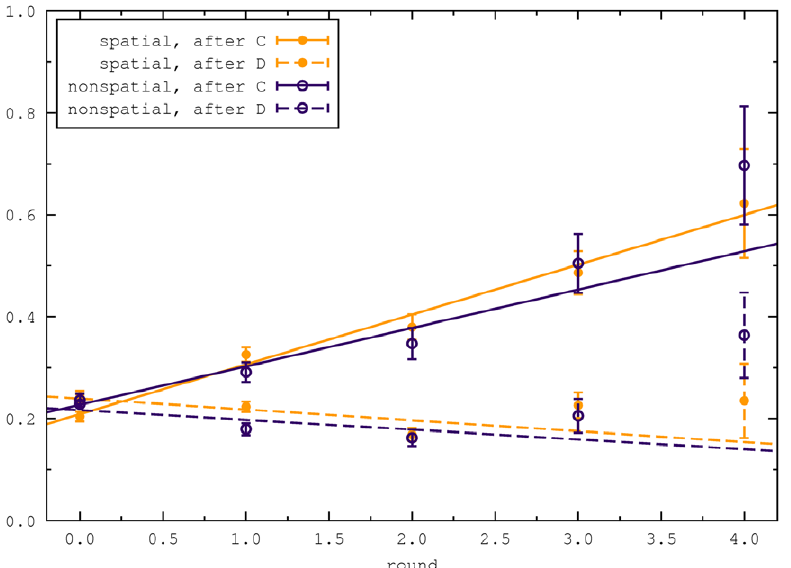
Figure 4. Probability of cooperation depending on the previous action and the number of cooperators in the neighborhood. These are called moody conditional cooperators in [36]. We see that there is a clear difference between the behavior after cooperating and defecting. After cooperating, the probability of cooperating increases with the number of cooperating neighbors and after defecting the probability of cooperation is decreasing with the number of cooperating neighbors. Again, in both the spatial and the non spatial setting the behavior is very